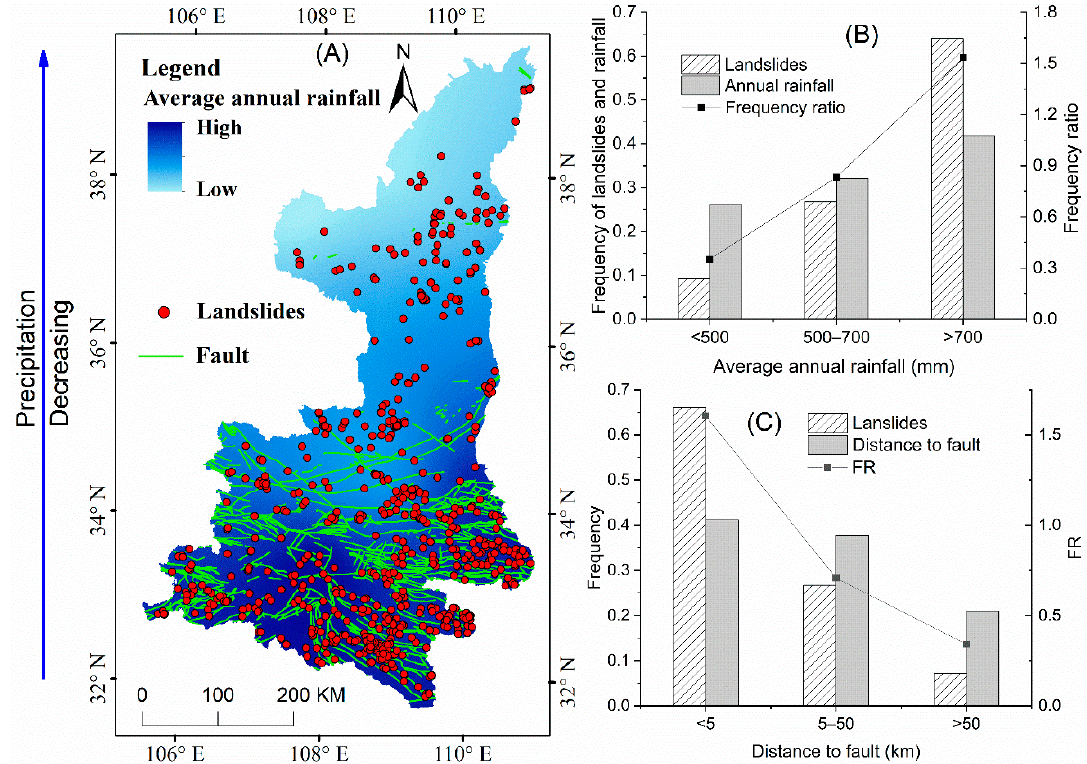
Figure 12. ( A ) Average annual rainfall and faults. ( B ) Relationships between landslides and average annual rainfall. ( C ) Relationships between landslides and distance to fault.